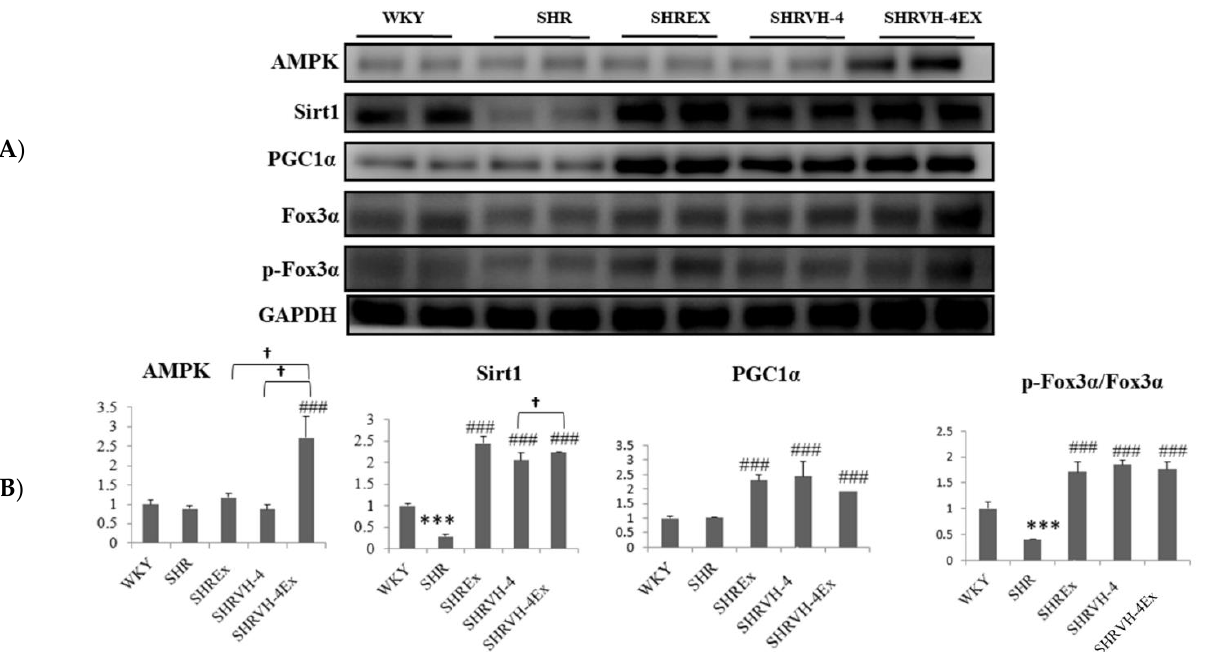
Figure 4. Effect of VH-4 and exercise training on AMPK α 1, Sirt1, PGC1 α , and FoX3 α signaling pathway in SHR animals. ( A ) Western blot of AMPK α 1, Sirt1, PGC1 α , and FoX3 α . ( B ) Graph showing densitometric analysis. *** p < 0.001 compared to WKY, ### p < 0.001 compared to SHR, and † p < 0.05 compared to SHR + EX and/or SHR + VH-4.